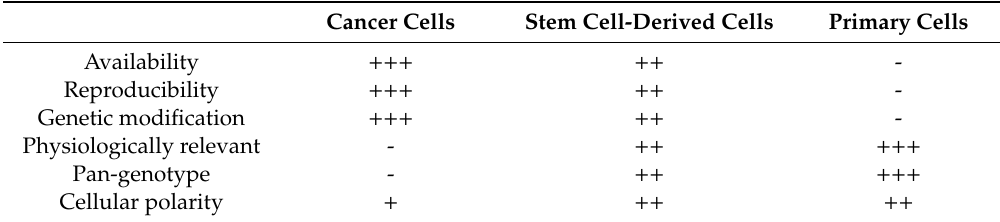
Table 2. Comparison of available cell systems for HEV